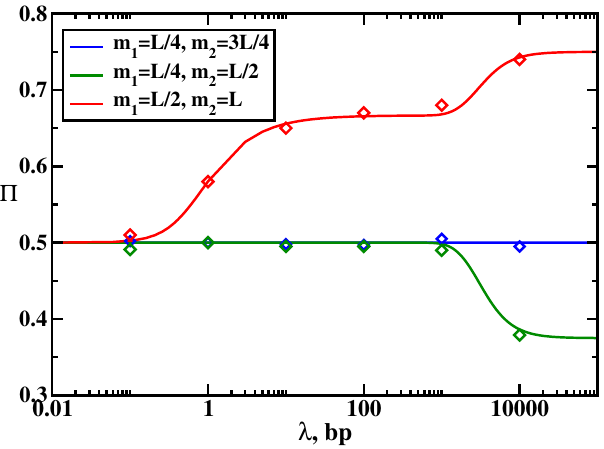
Figure 6. Probability to reach the target as a function of the scanning length for different distributions of the target and trap sites. Parameters used for calculations are: k on = u = 10 5 s − 1 , L = 10,000 and k of f is changing. Symbols are from Monte Carlo computer simulations. Adapted with permission from Ref.